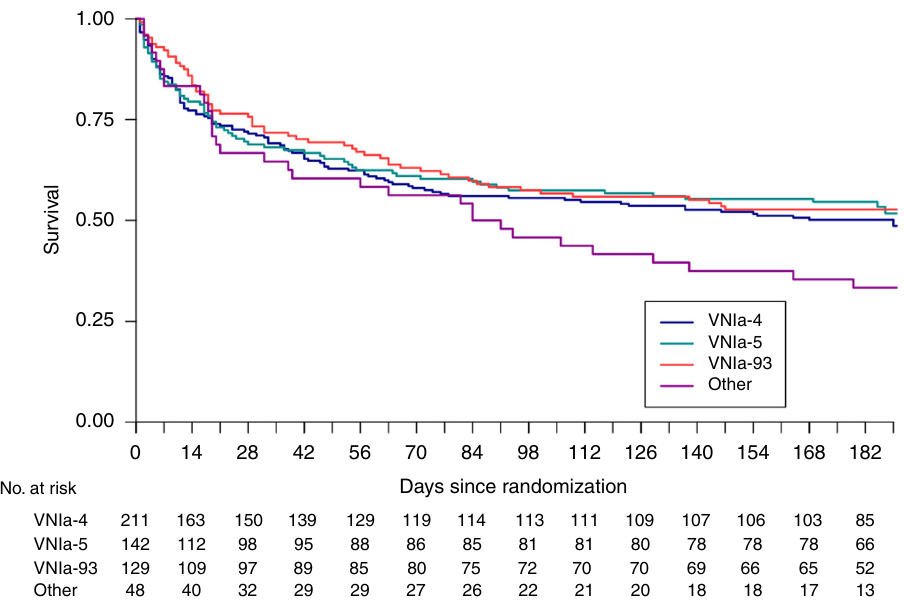
Fig. 3 Kaplan – Meier survival estimates up to 6 months for all 530-HIV infected patients enroled in one of two clinical trials (Day et al. 20 ; Beardsley et al. 21 ) with whole-genome sequencing results for their infecting